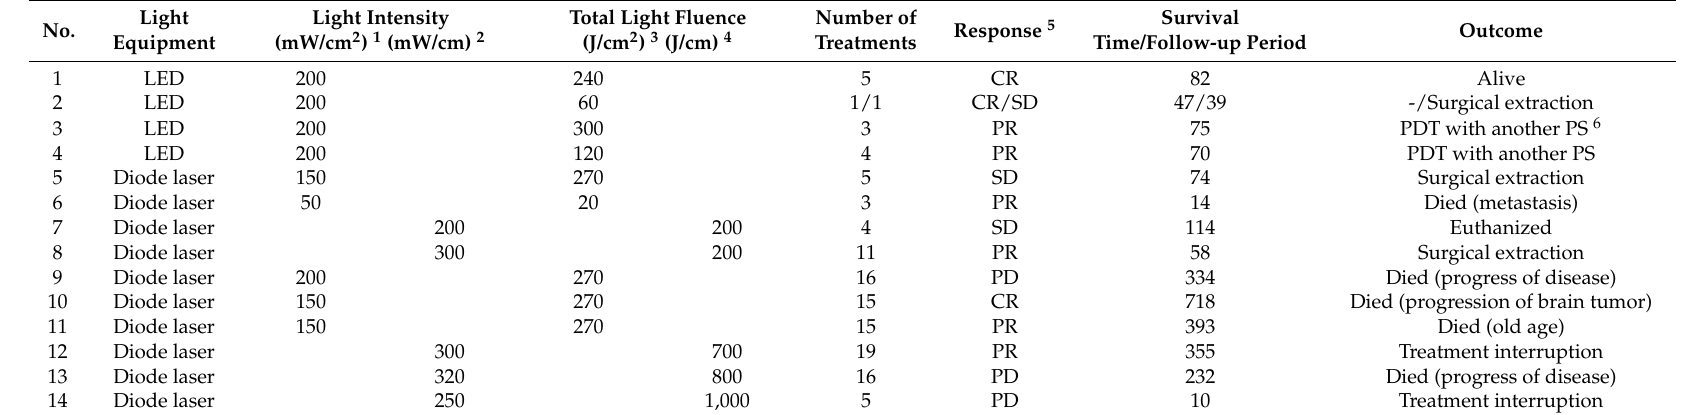
Table 3. Response of tumors to photodynamic therapy using 5-aminolevulinic